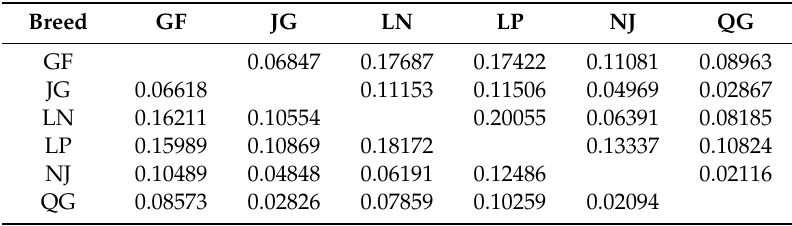
Table 4. Reynolds’ genetic distances (above diagonal) and pairwise differences (below diagonal) among four Chinese goat populations.